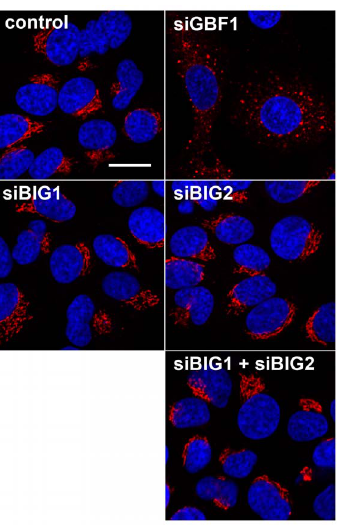
Figure 9. Impact of Arf-GEF depletion on the cis-Golgi morphology. Huh-7 cells were transfected with siRNA targeting GBF1, BIG1, BIG2, or both BIG1 and BIG2. Cells were fixed 3 days after transfection and processed for the immunofluorescent detection of GM130 (shown in red). The nuclei were stained with DAPI (shown in blue). Representative confocal images are presented. Bar, 20 m m.